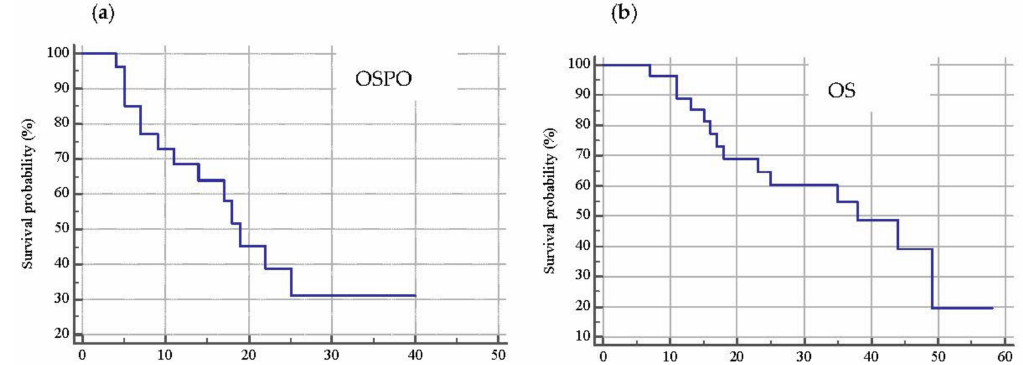
Figure 4. Kaplan–Meier curve representative of overall survival post oligoprogression (OSPO) ( a ) whose median value was 19 months (range 11–25; 95% C.I.) and overall survival (OS) ( b ) with a median value of 38 months (range 18–49; 95% C.I.). At time of analysis, 13 patients were